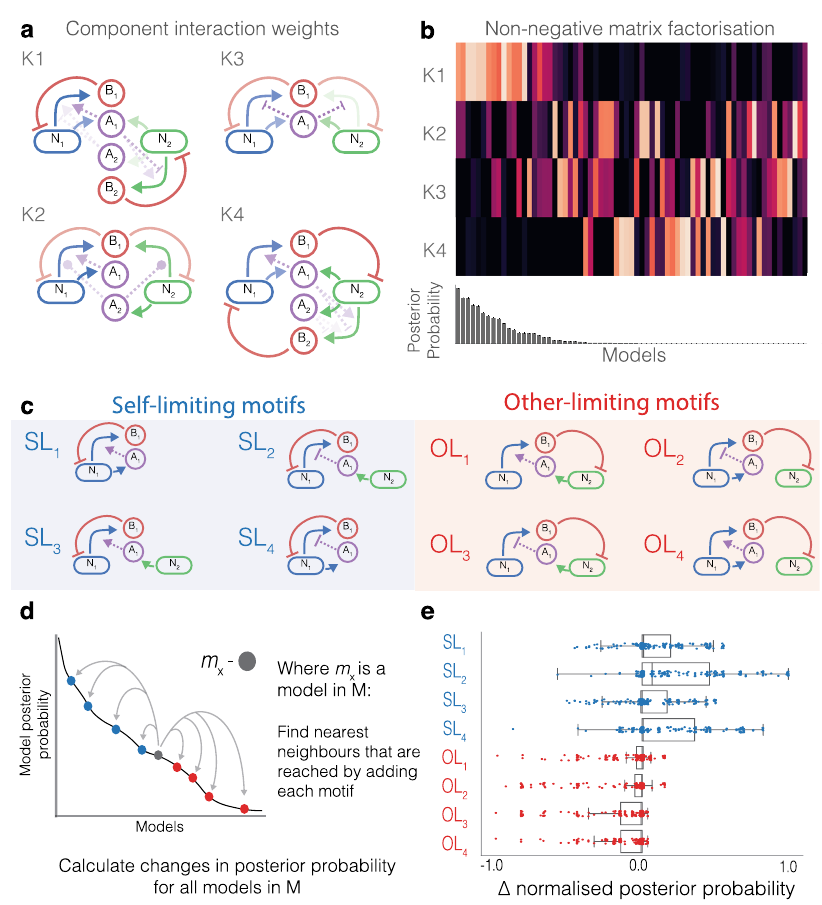
Fig. 3 Contribution of network motifs to stability. a , b Non-negative matrix factorisation (NMF) analysis to learn motifs in model space using four components ( K = 4). a Four components learned by NMF, the line opacity indicates the coef fi cient of the interaction. b Visualisation of the component weights for each model. Each column is a model, with light colours corresponding to high weight and dark colours low weight. c – e Manually curated minimal motifs capture interaction importance. c Minimal motifs split into self-limiting (SL) and other-limiting (OL) by the direction of bacteriocin killing. d Illustration of the algorithm used to generate each datapoint in e . Moving from a model to the nearest neighbours that can be built by adding a motif will produce a change in model posterior probability. e Boxplots and scatter plot showing the change in posterior probability when adding each motif to a model. The boxplots show the median, fi rst and third quartile. The lower and upper whiskers mark the 5th and 95th percentiles, respectively. n = 224 for each